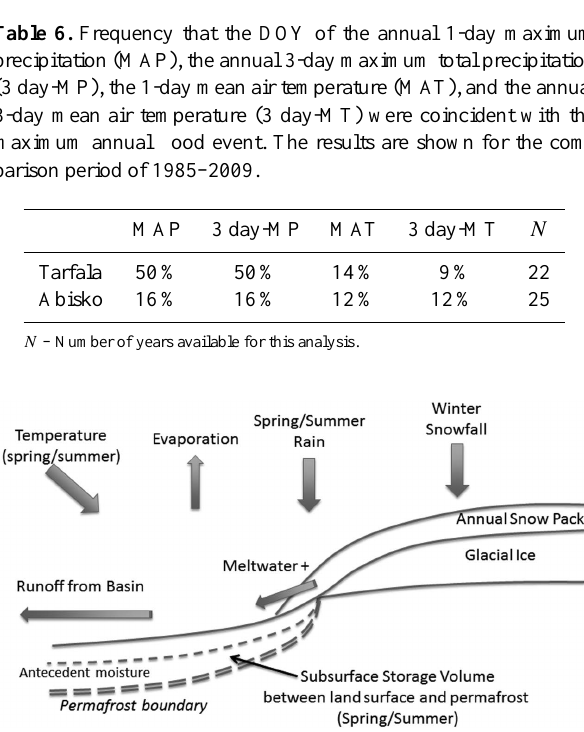
Fig. 6. Dominant hydrometeorologic and hydrologic processes af- fecting the annual discharge and generation of extreme flood peaks in the Tarfala and Abisko